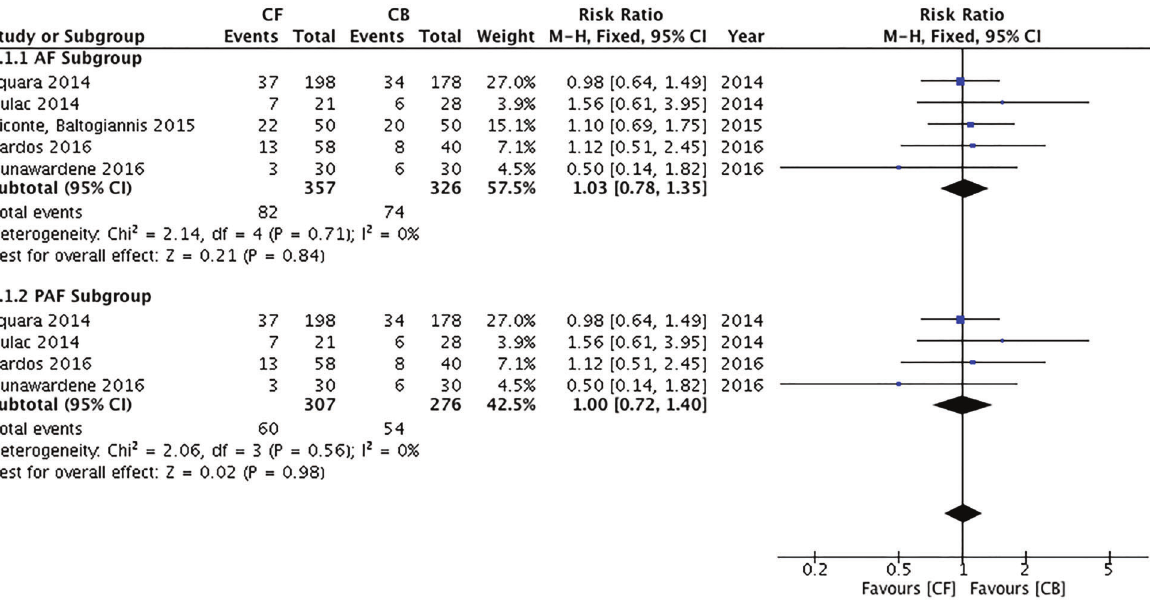
Braz J Med Biol Res | doi: